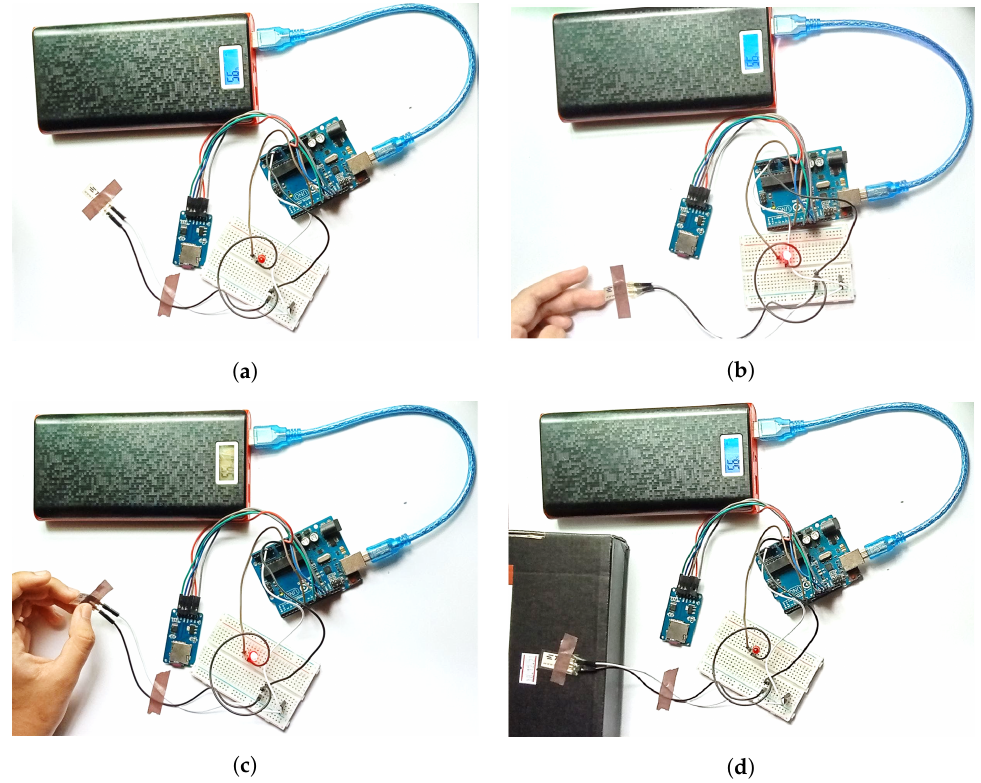
Figure 2. Experimental Set ups. ( a ) Ambient responses test; ( b ) Partially removed sensor; ( c ) Completely removed sensor; ( d ) Drop deformation